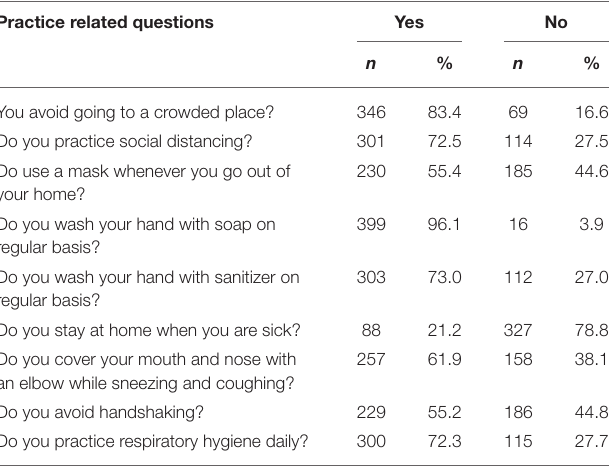
TABLE 4 | Frequency of respondent’s practice toward COVID-19, Dire Dawa administration residents, Eastern Ethiopia, May 2020 ( N = 415). Practice related